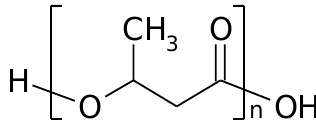
Figure 2. The fragment of polyhydroxybutyrate structure.